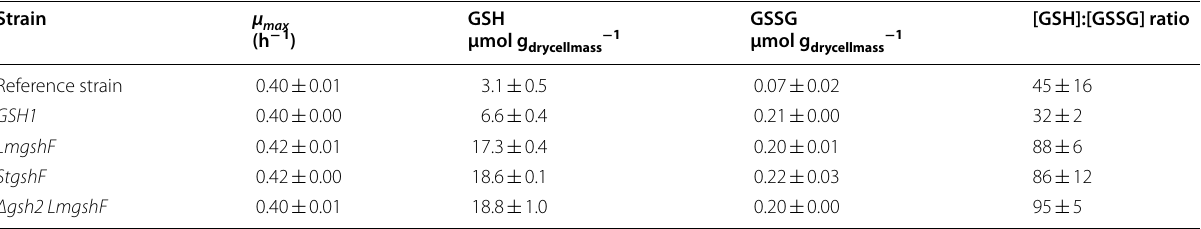
Data represent the mean standard deviation (n 2). Total GSH is the sum of GSH and GSSG. Ask et al. (2013b) overexpressed GSH1 in a prototrophic CEN.PK 113-7D ± = background and reported a GSH content of 12.2 µmol g drycellmass − 1